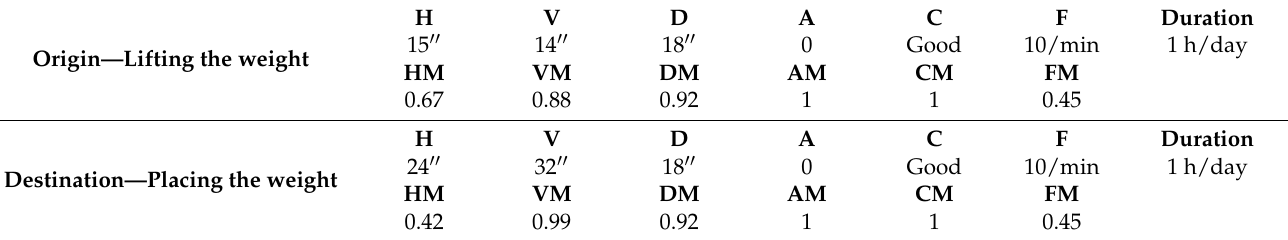
Table 2. NIOSH Lifting Equation Multipliers According to Table 1 and Figure 1.